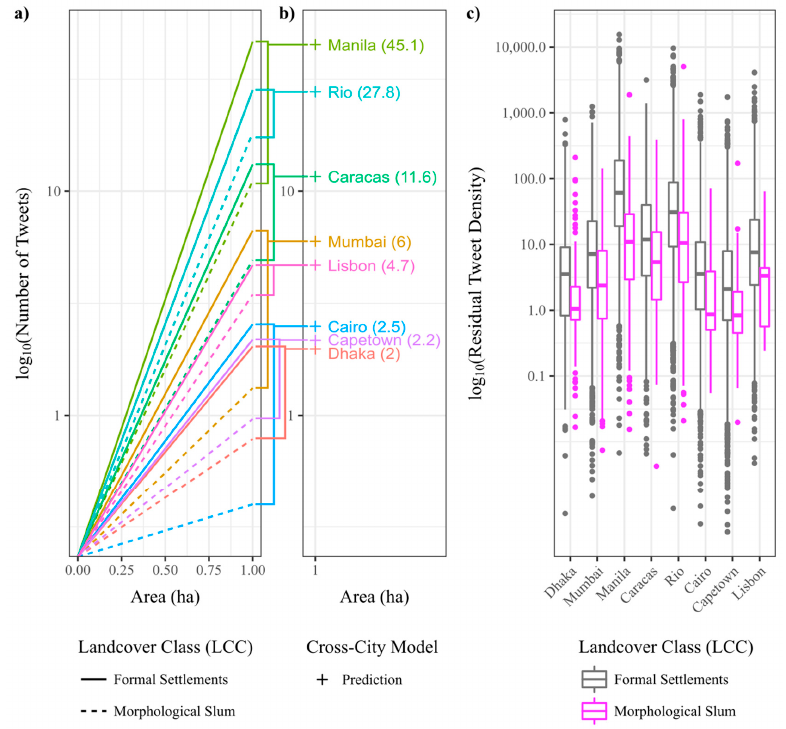
Figure 4. Empirical statistics on tweet densities, as well as the cross-city model residuals: ( a ) Linear models illustrating tweet density depending on city and land cover class; ( b ) Cross-city model combing both land cover classes used to extract overall tweet densities for each city; ( c ) Residual tweet density after city-specific covariation was removed.